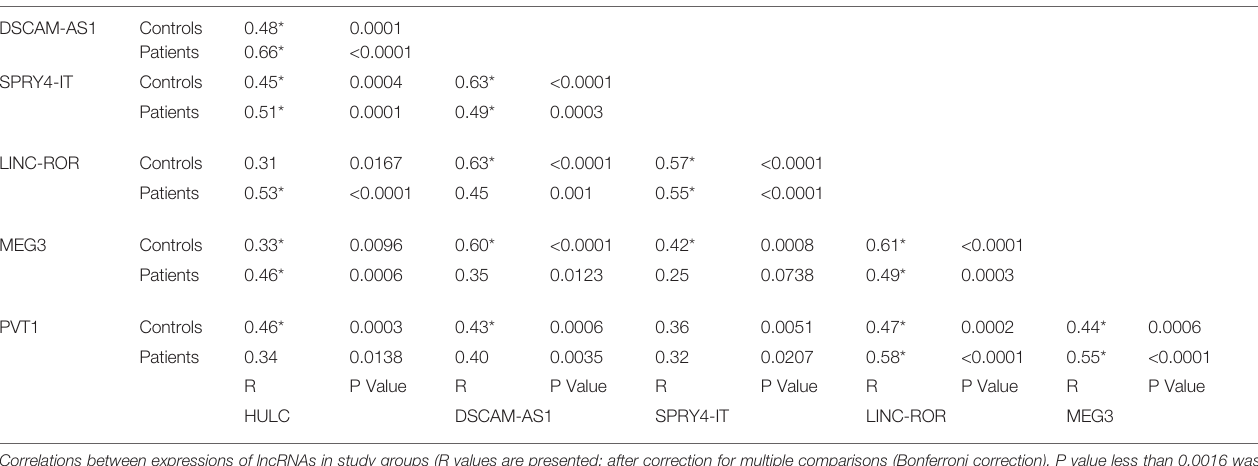
TABLE 6 | Correlations between expressions of lncRNAs in study groups.